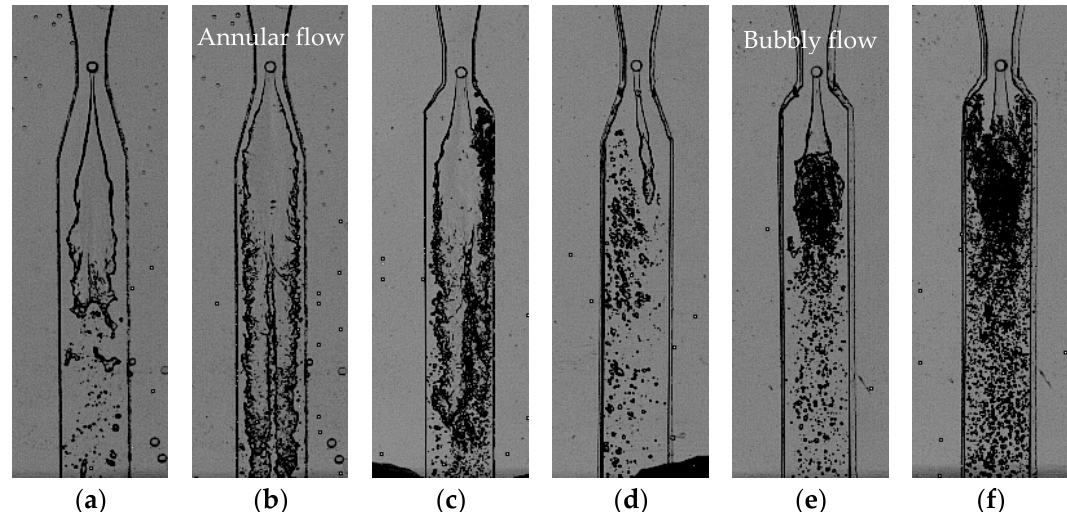
Figure 3. Visualized images of water–air two ‐ phase flows at the pressure ratio of 0.02 according to water flow rate and diverging angle: annular flow ( a ) α = 30°, Q water = 400 mL/min, ( b ) α = 30°, Q water = 700 mL/min, ( c ) α = 70°, Q water = 700 mL/min; bubbly flow ( d ) α = 40°, Q water = 500 mL/min, ( e ) α = 80°, Q water = 500 mL/min, ( f ) α = 80°, Q water = 700 mL/min.